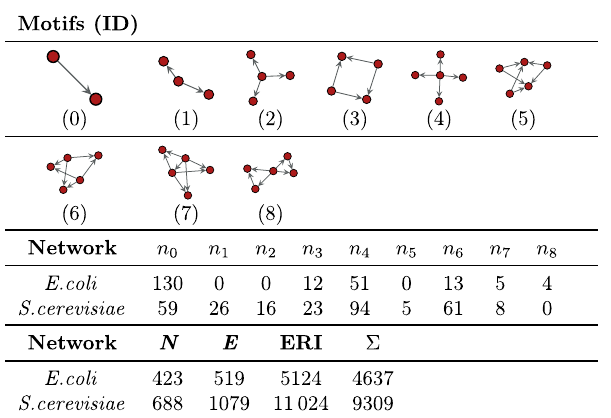
TABLE V. The motifs of various metabolic networks obtained using biconnected subgraphs up to size